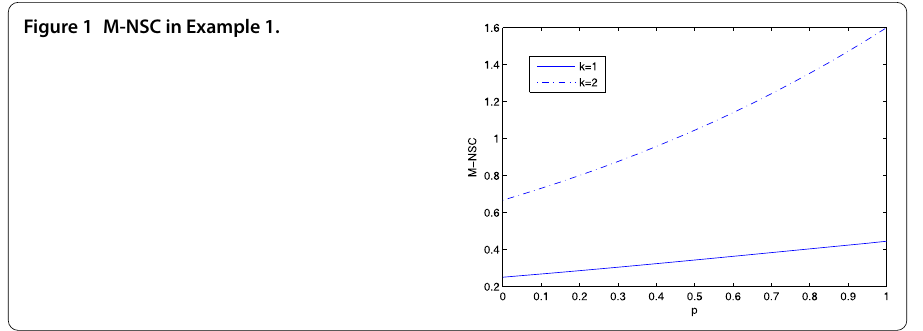
Figure 1 M-NSC in Example